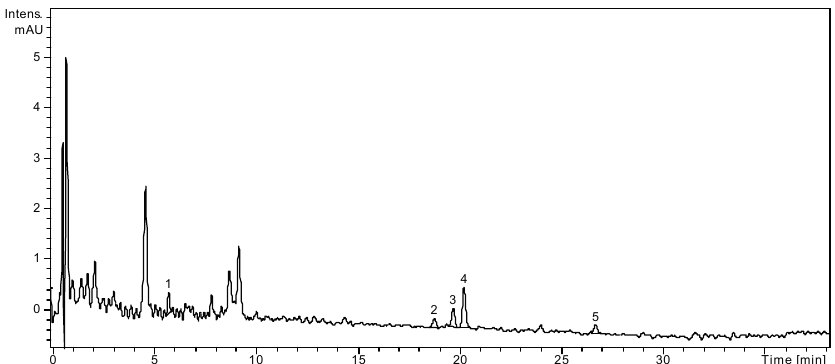
Figure 2. HPLC chromatogram of S. chinensis fruits